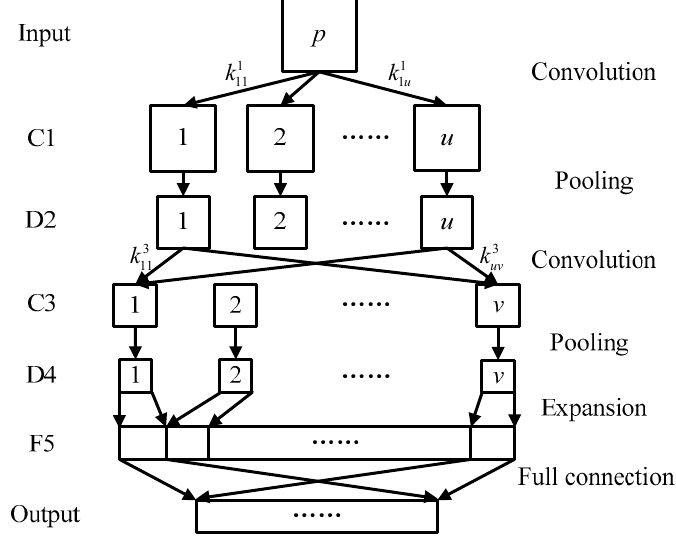
Figure 1. Two-convolution-layer convolution neural network (CNN).